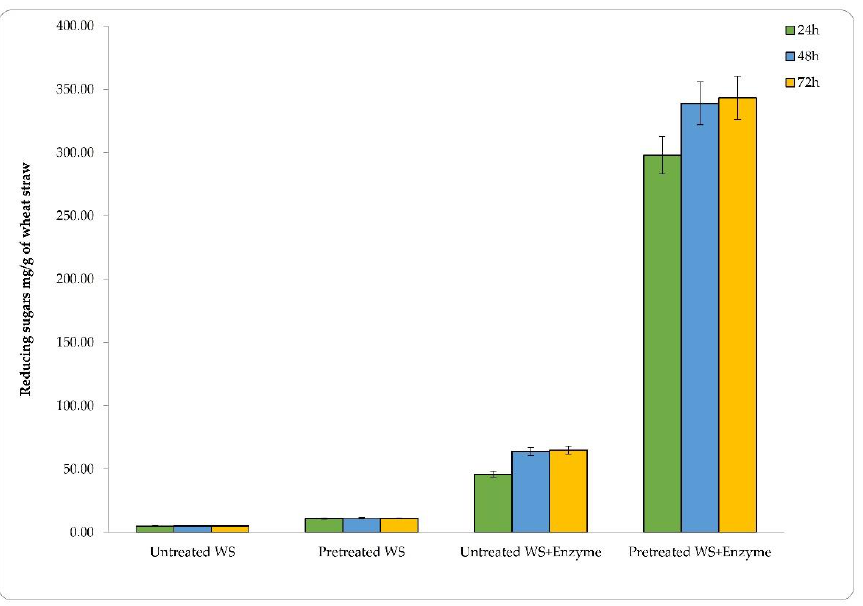
Figure 2. Reducing sugars obtained from untreated and NaOH-pretreated wheat straw, with or without the fungal crude enzyme.